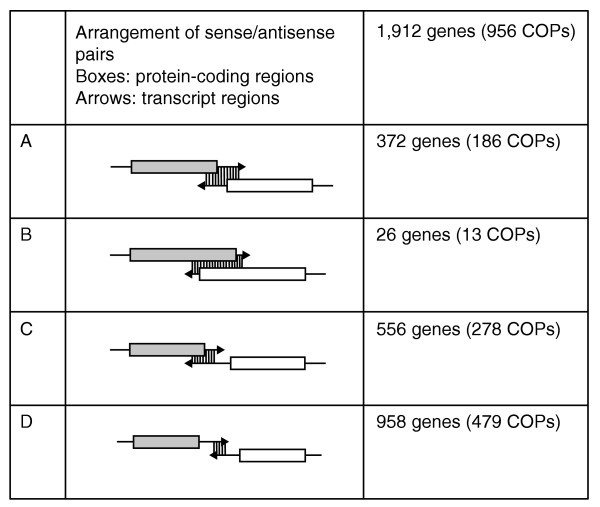
The organization of convergent overlapping gene pairs with respect to the protein coding capacity of the sense and antisense transcripts.